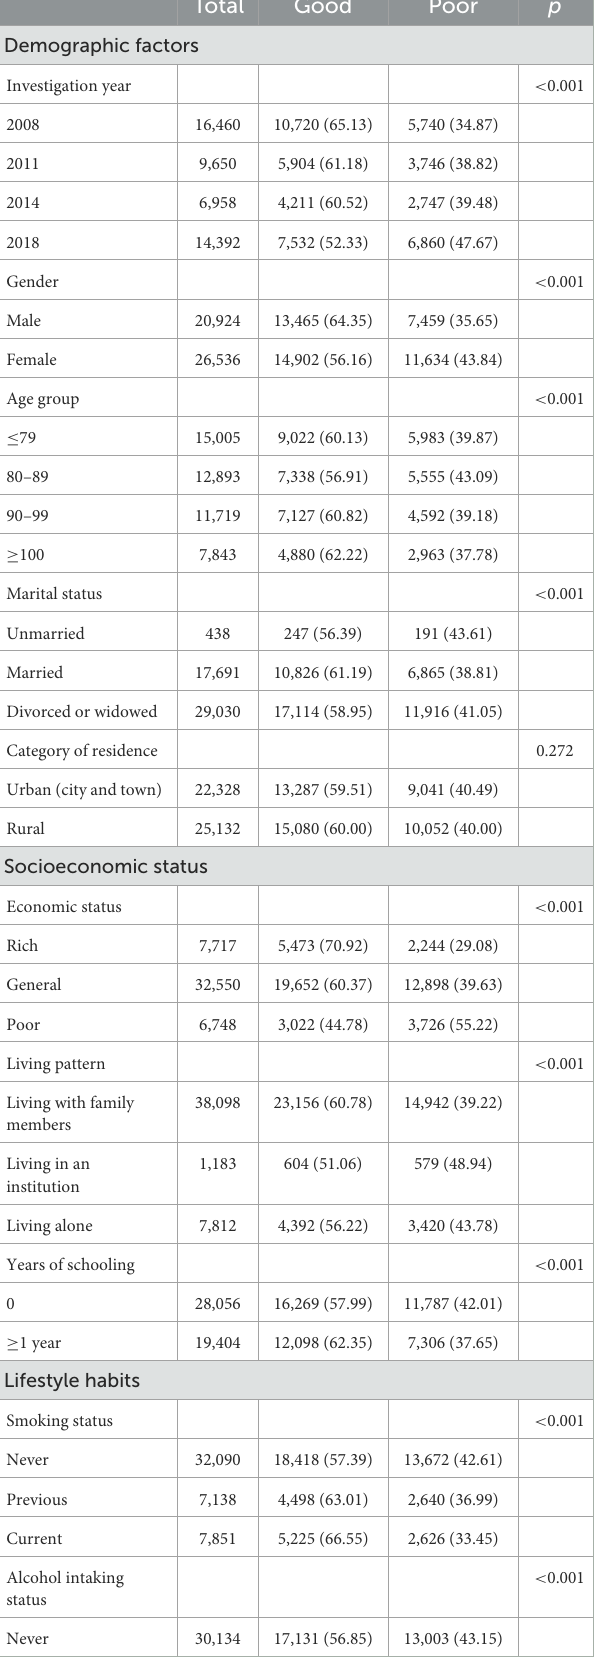
TABLE 1 Trends and disparities in sleep quality among older people in China from 2008 to 2018. Good